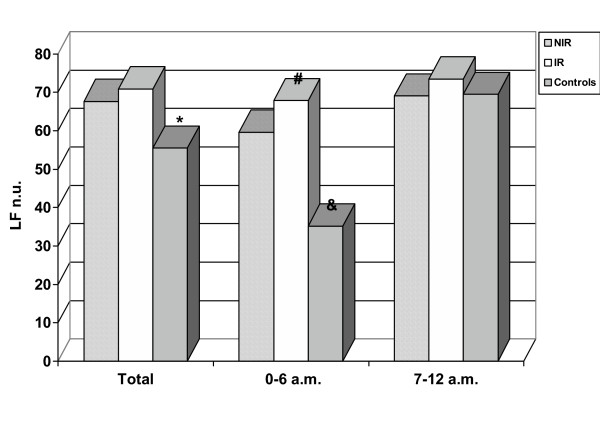
LF value in offsprings of type 2 diabetic patients and control. IR: insulin resistant offsprings of type 2 diabetic patients, NIR: non insulin resistant offsprings of type 2 diabetic patients, LF: low frequency, hours of Holter registration: 0–6 am= night time, 7–12 am = morning. * p < 0.001 NIR and IR vs controls, #: p:0.001 IR vs NIR; & p < 0.001 controlsvs NIR and IR.